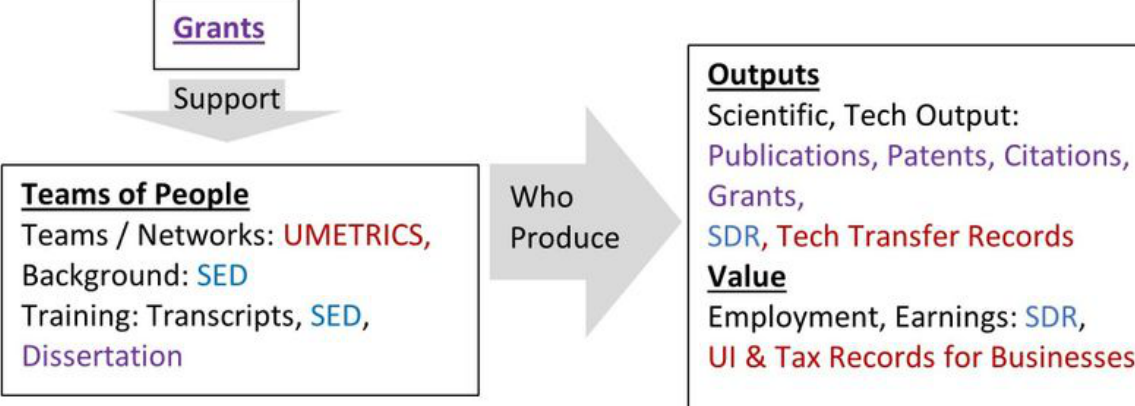
Figure 2. Types of data and roles. The figure illustrates the types of data elements that can be brought to bear to understand how research support affects researchers and teams, output, and the economy. Blue indicates survey data. Red indicates transactional data. Purple indicates naturally occurring data and bibliometric data, which are both unobtrusive. SDR = Survey of Doctorate Recipients; SED = Survey of Earned Doctorates. UMETRICS = Universities Measuring the EffecTs of Research on Competitiveness, Innovation and